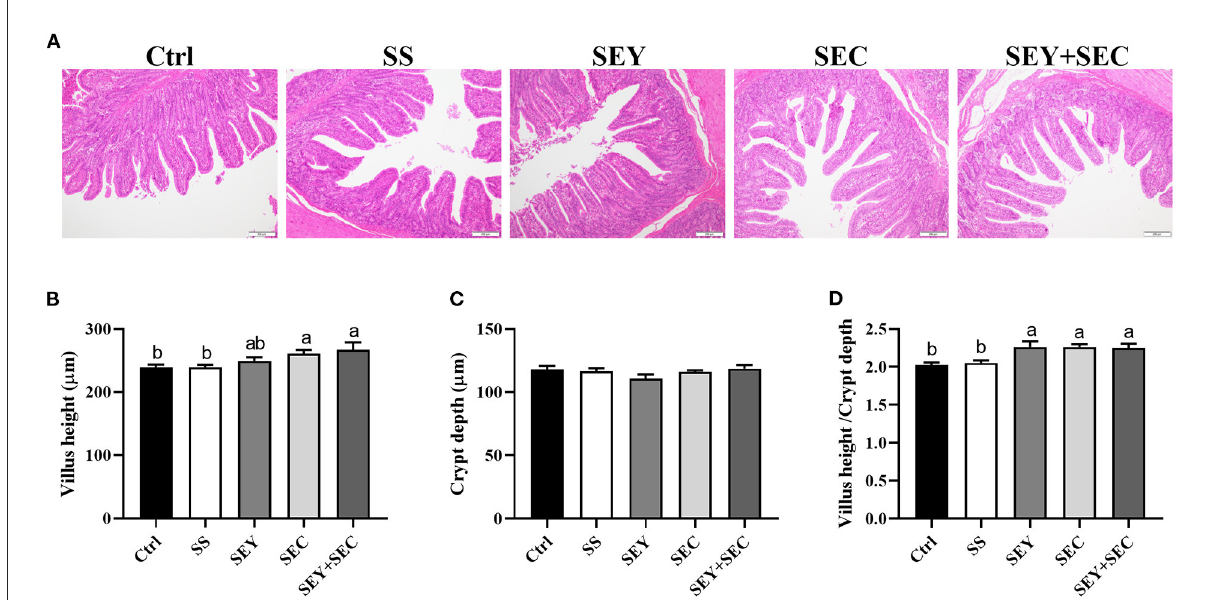
FIGURE1 Effects of different Se sources on jejunal morphology in piglets. (A) The histopathology of jejunum by H&E staining, Scale bar, 100 µ m; (B–D) The villus height (B) , crypt depth (C), and villus height/ crypt depth ratio (D) in the jejunum. Values are means ± SEM, n = 4–6. a,b Means without a common letter differ, P < 0.05. Ctrl, control group; SS, sodium selenite; SEY, Se-enriched yeast, SEC, Se-enriched Cardamine violifolia ; SEY + SEC, Se-enriched yeast + Se-enriched Cardamine violifolia .